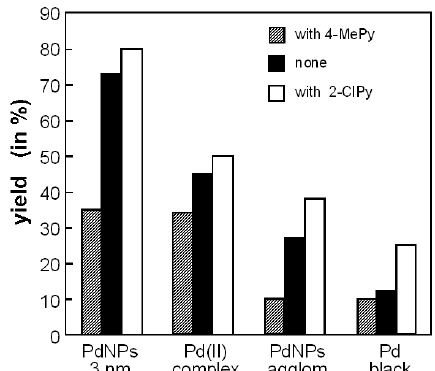
Figure 3. The yield of aniline obtained from nitrobenzene reduction with CO/H 2 O in the presence of 0.056 mmol PdNPs/4MePy (3 nm), PdCl 2 (4MePy) 2 complex, PdNPs (agglomerated) and Pd black /4MePy.